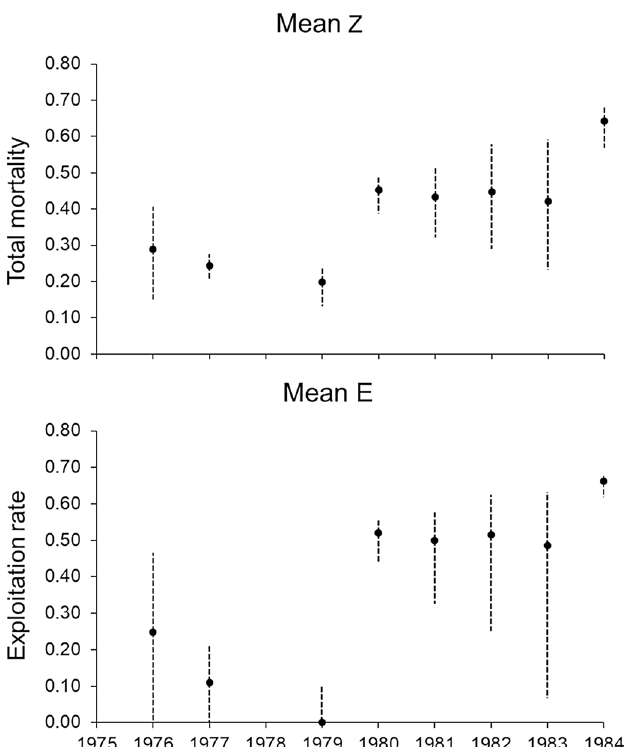
Fig. 13. Annual total instantaneous mortality coef fi cient Z (upper panel) and exploitation rate E (lower panel) of Pagrus pagrus fi shed in southern Brazil between 1976 and 1984. Vertical bars represent 95% bootstrap con fi dence intervals.